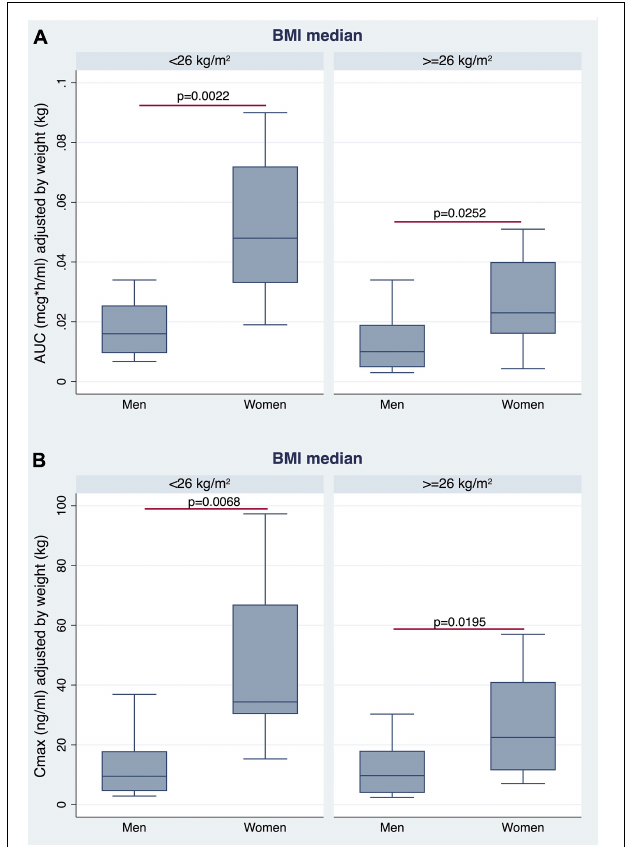
FIGURE 9 | Correlation between t 1 / 2 (min) values and BMI (kg/m 2 ) in the whole population (A) and stratifying by sex (B)